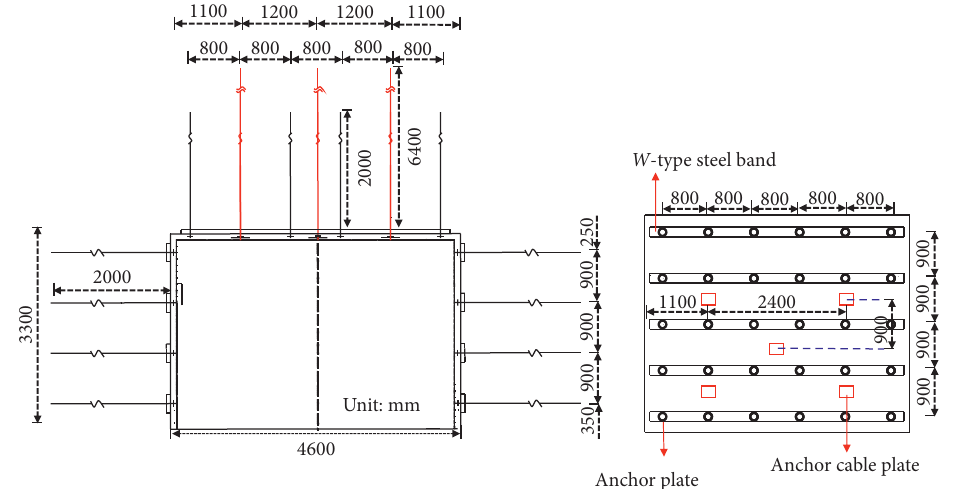
Figure 14: N102 headgate support